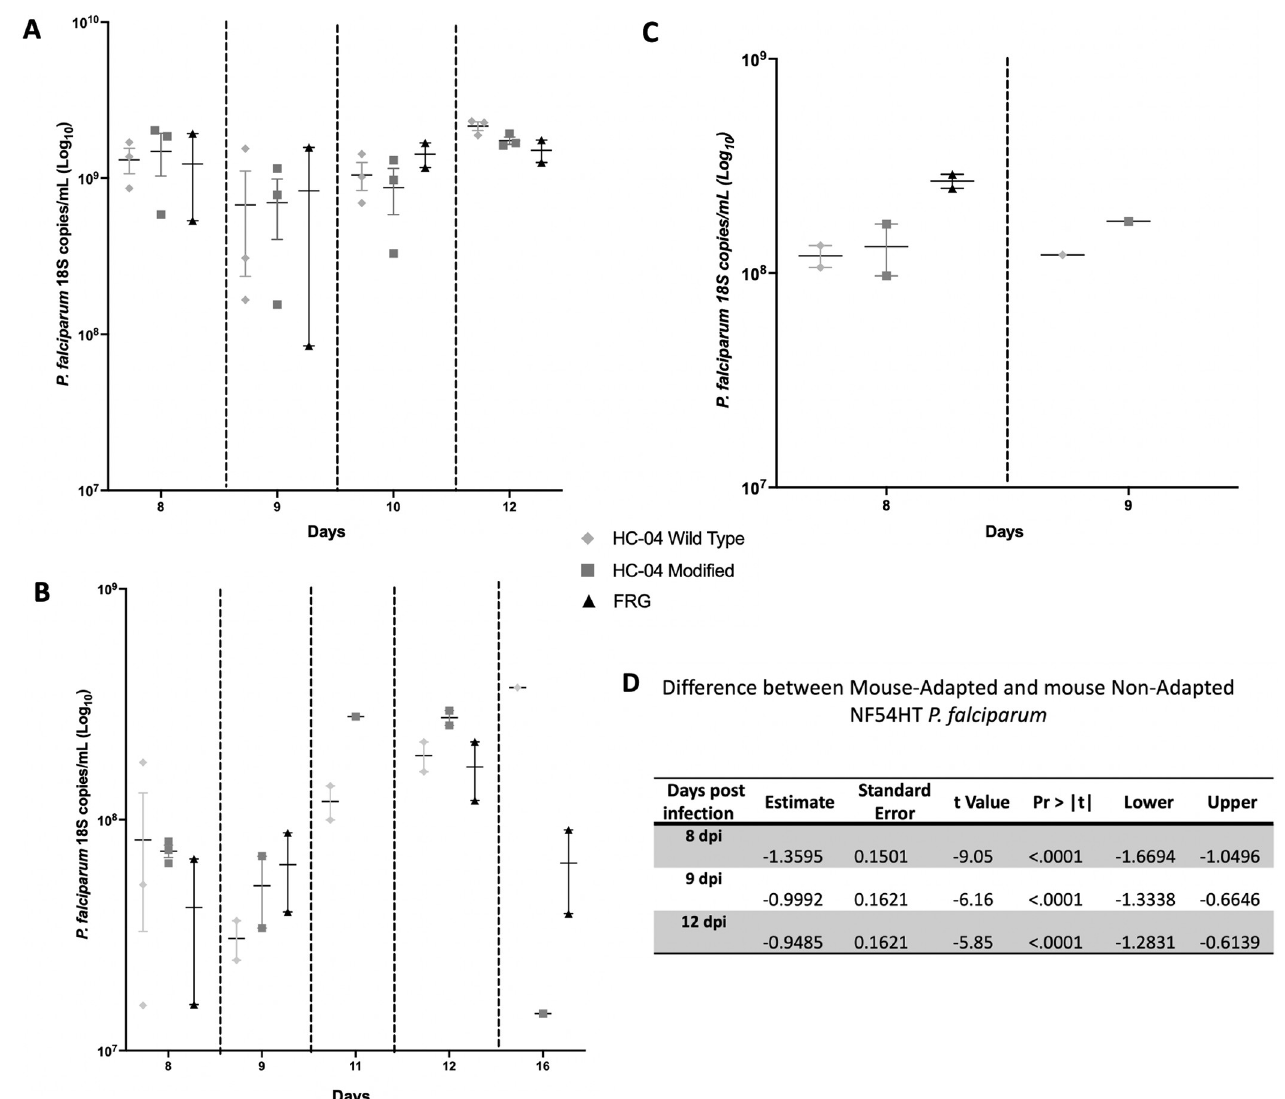
Fig 4. Comparison of NSG ectopic huLiver infection to the FRG-huHep infection model with the P . falciparum strain NF54HT with three adaptations. Transition from liver to blood-stage infection was quantified using qRT-PCR to detect P . falciparum 18S rRNA expression in both the ectopic huLiver engrafted NSG and FRG-huHep infection models. (A) P . falciparum 18S rRNA expression in mosquito bite infected mice from each model (HC-04 WT n = 3, HC-04 modified n = 3 FRG-huHep n = 2) with the non-mouse adapted NF54HT P . falciparum strain. Blood samples were collected at 8 through 12 dpi. (B) P . falciparum 18S rRNA expression in mosquito bite infected mice from each model (HC-04 WT n = 3, HC-04 modified n = 3 FRG-huHep n = 2) with the mouse adapted NF54HT P . falciparum strain. Blood samples were collected at 8 through 16 dpi. (C) Statistical Analysis showing differences between mouse-adapted and non-mouse adapted NF54HT P . falciparum at day 8, 9 and 12 post infection. (D) Ectopic huLiver engrafted NSG (HC-04 WT n = 2, HC-04 modified n = 2) and FRG-huHep mice (n = 3) were infected by mosquito bite using P 0 of NF54HT-GFP-luc, generated from the first completed life cycle passage within FRG-huHep. Blood samples were collected 8 and 9 dpi for qRT-PCR analysis of P . falciparum 18S rRNA expression. https://doi.org/10.1371/journal.pone.0279144.g004 Finally, we used the P NF54HT-GFP-luc P . falciparum strain to infect both the FRG- 0 huHep and ectopic huLiver mice. Transition to blood-stage infection was followed over time in all mice using qRT-PCR to detect P . falciparum 18S rRNA. Results indicated all mice had infection, with ectopic huLiver albeit at a slightly lower infection than FRG-huHep mice (Fig 4C). Infection levels were between 10 8 parasites for ectopic huLiver and 10 9 parasites for FRG-